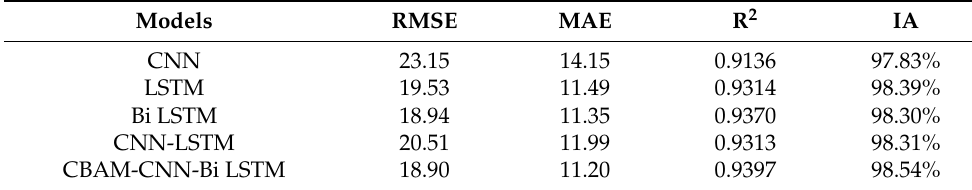
Table 4. Performance evaluation indicators for model single-step